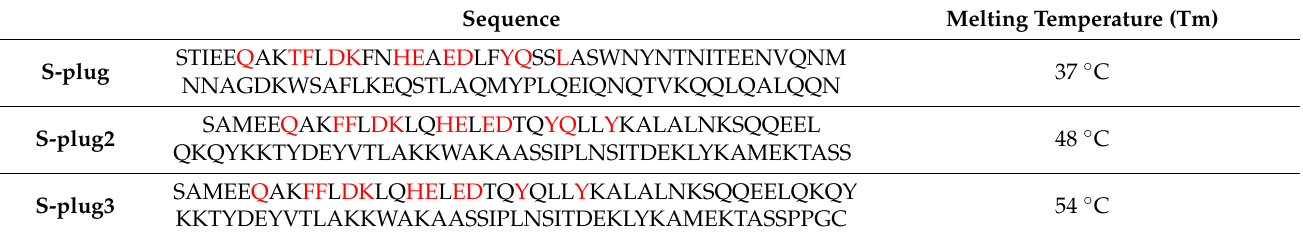
Table 1. Sequences of developed S-plugs. Most relevant residues for ACE2 interactions with spike RBD are reported in